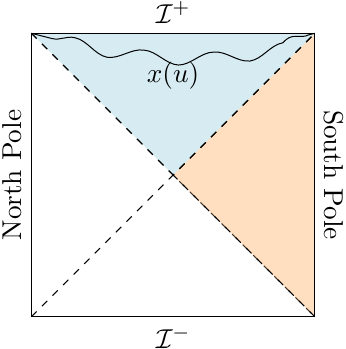
Figure 2 . The Penrose diagram of three-dimensional de Sitter. Each point represents a circle. The static patch for an observer at the south pole is indicated in orange; the dashed lines are the horizons. The Milne (future) patch is indicated in blue. We will make use of the fluctuating boundary geometry at I + described by a Schwarzian action. I − does not play a role in our considerations as we consider a quantum state that is singular at the past